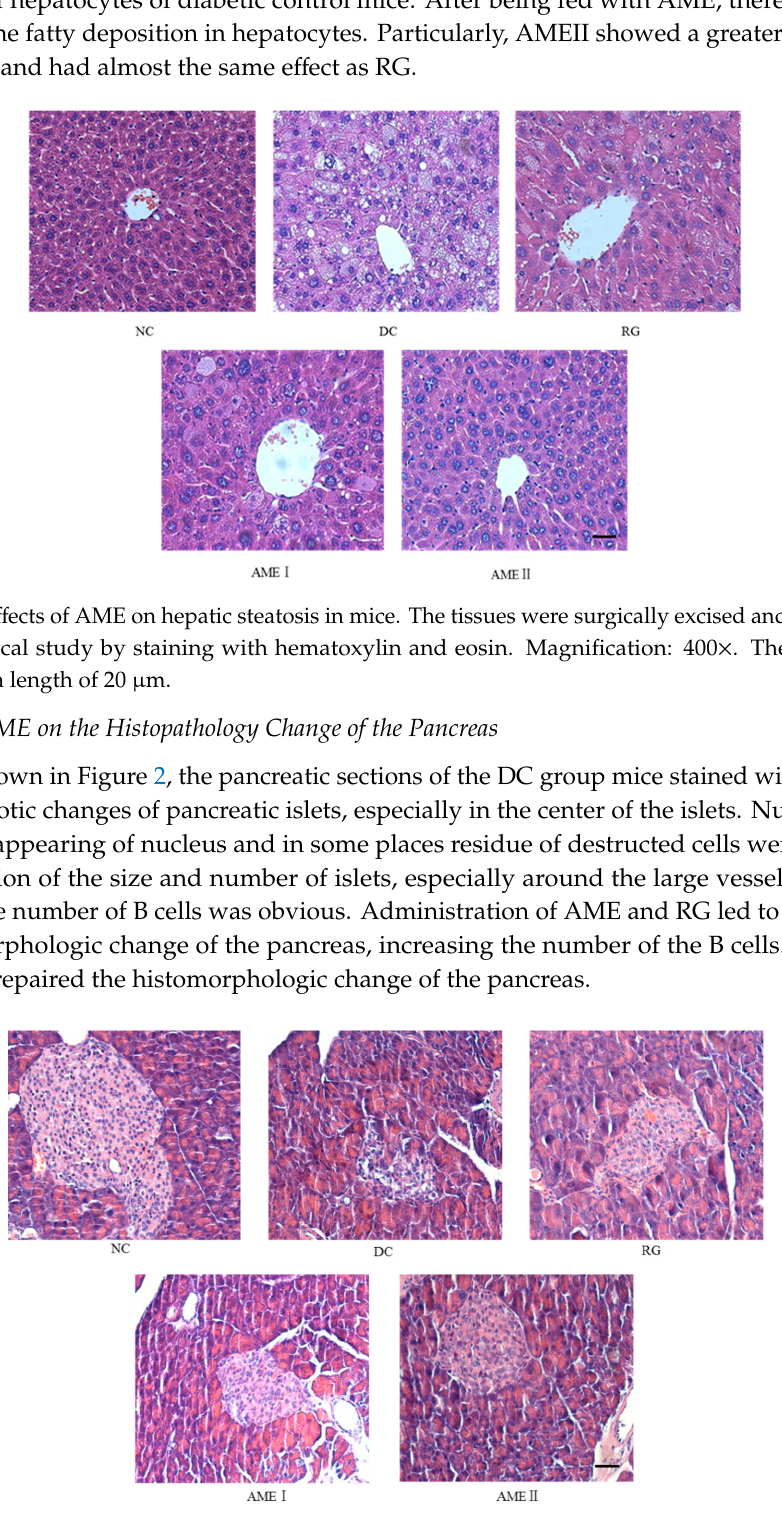
Figure 2. Effects of AME on the histopathology of the pancreas histomorphologic change of pancreas. The tissues were surgically excised and subjected to histological study by staining with hematoxylin and eosin. Magnification: 400 × . The scale bar represents a length of 20 μ m.